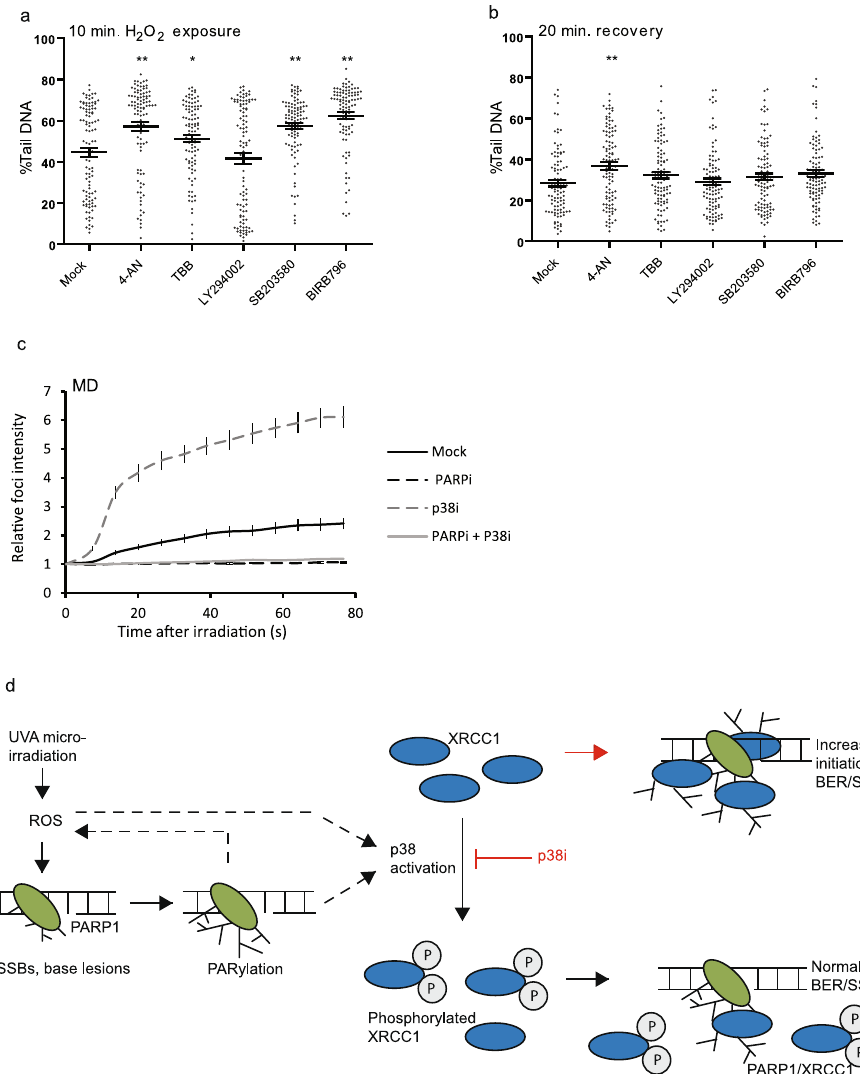
Figure 3. Effect of PARP- and kinase inhibitors on repair and recruitment to DNA damage. ( a , b ) Comet analysis of PARylation- and kinase inhibitor treated cells harvested after 10 minutes of H 2 O 2 insult (47 µ M) ( a ) and after 20 min recovery ( b ). Dot plot of cells treated with 0.25% DMSO (mock), 10 µ M 4-AN (PARPi), 25 µ M TBB (CK2i), 25 µ M LY294002 (PI3Ki), 25 µ M SB203580 (p38i), or 25 µ M BIRB0796 (p38i). Averages of n = 100 ± SEM. One out of four similar experiments is shown. Asterisks represent Student’s t-test p-values from the corresponding kinase/PARylation inhibitor treated vs. mock treated samples, where ** p < 0.001, * p < 0.05. ( c ) Average fold increase in mIF intensities of YFP-MD in cells treated with either 0.25% DMSO (Mock), 10 µ M SB203580 (p38i) and/or 10 µ M PJ34 (PARPi) at a 1x laser dose. Mock: n = 11, p38i: n = 11, PARPi: n = 5, PARPi + P38i: n = 6. ( d ) Model of PAR and p38 signaling in recruitment and repair of SSBs and base lesions. Dashed arrows illustrate possible ways of p38 activation. Red arrow and line indicate preferred pathway in presence of